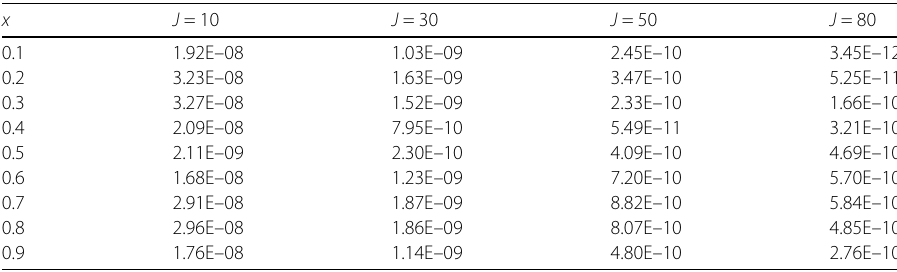
Table 1 Absolute error of numerical solution at τ = 0.02